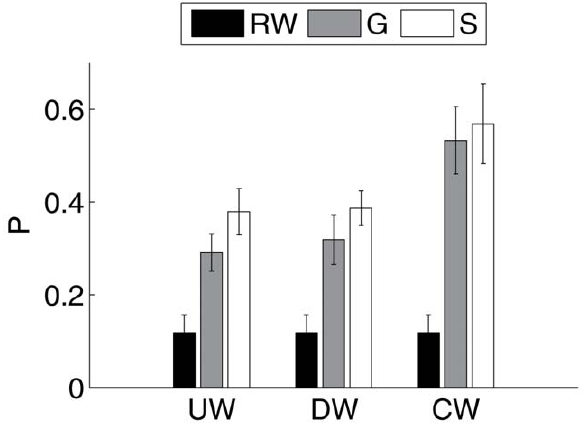
Figure 4. The proportion of mosquitoes finding a host within 150 s. The black bars are the results for a random walk (RW) without wind and CO 2 , the gray for the gradient method (G) of concentration sensing, and the white for the sampling method (S) of concentration sensing. UW=upwind plume finding, DW=downwind plume finding, and CW=crosswind plume finding. The thin error bars are + 2 standard deviations. If the simulation is allowed to progress beyond 150 s, then no appreciable changes occur in the results for the host-seeking methods, but the random walk continues to accrue contacts.